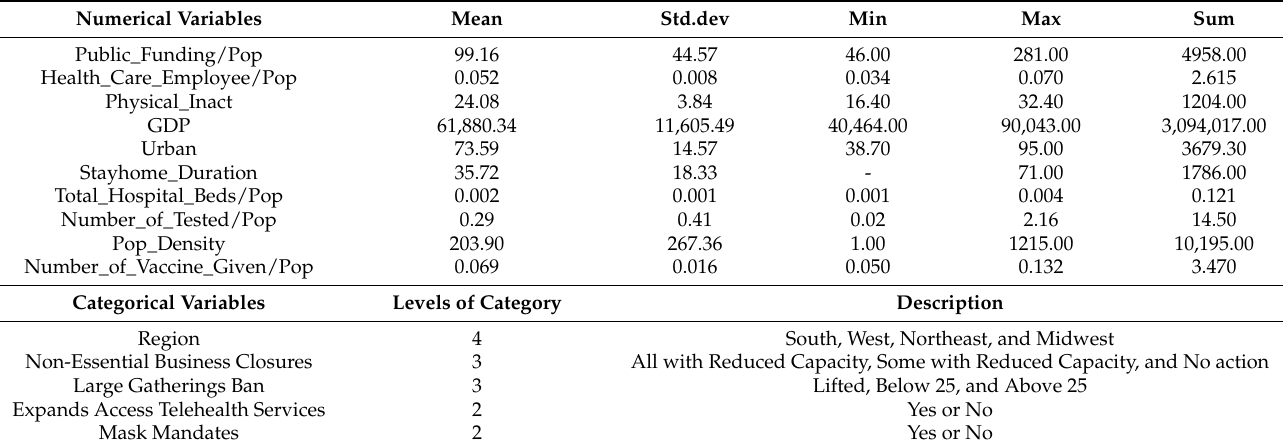
Table 5. Descriptive Statistics of Environmental Factors used in ML